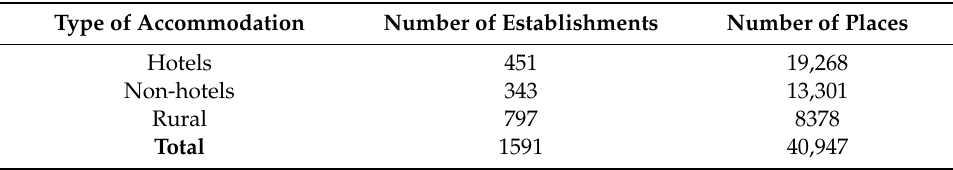
Table 1. Tourism Magnitude of Extremadura (year